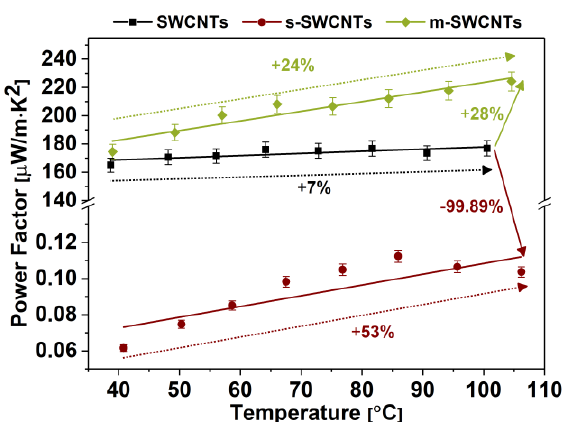
Figure 9. Power Factors (PFs) of thin films from unsorted, metallic, and semiconducting SWCNTs. Horizontal arrows compare the increase or decrease of initial Power Factor of metallic and semiconducting films as related to the parent material. The arrows, which span across selected temperature ranges, on the other hand, compare the Power Factors of the respective SWCNT networks as related to the initial value of Power Factor recorded at the starting temperature.